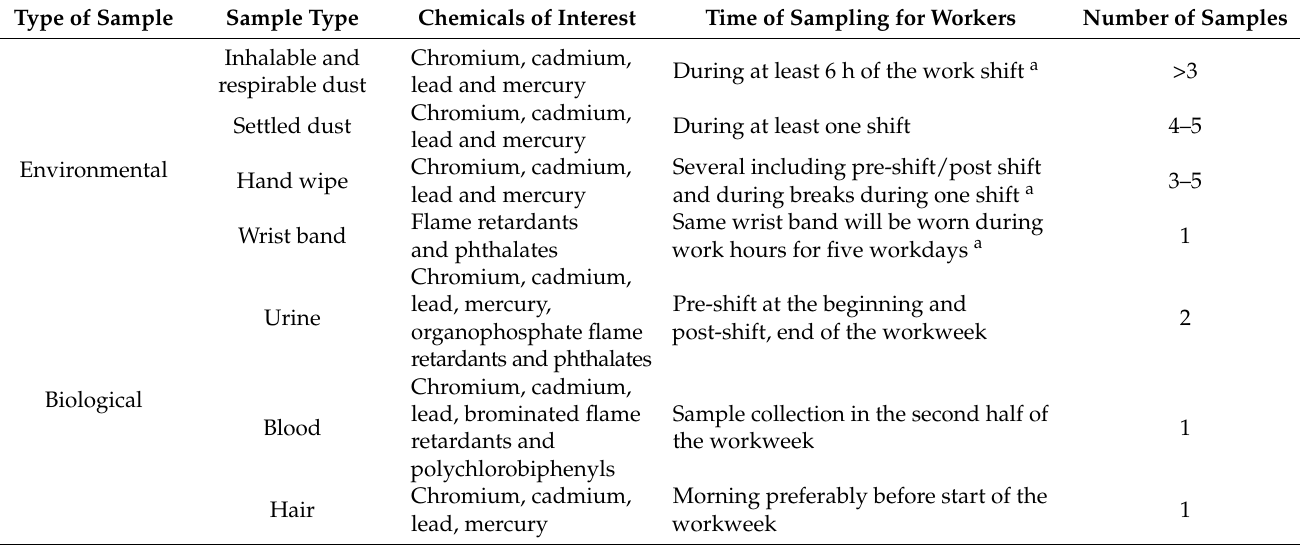
Table 2. Environmental and biological samples for determination of exposure